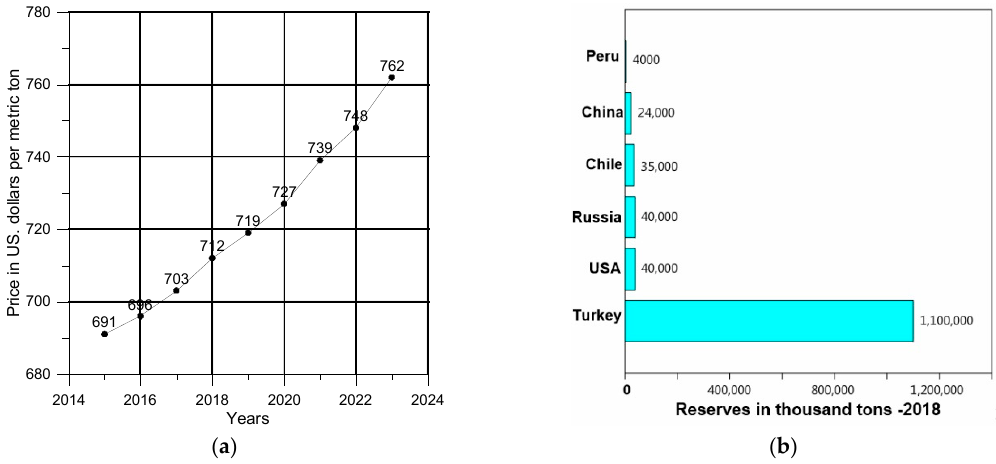
Figure 2. ( a ) Medium-term forecast for boric acid prices worldwide from 2015 to 2023 [31], ( b ) world boron reserves as of 2019, by major countries